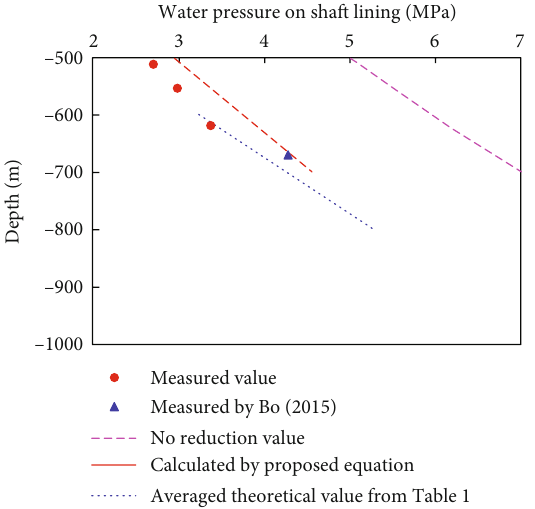
Figure 9: The measured water pressure on coal mine shaft linings in western China and its